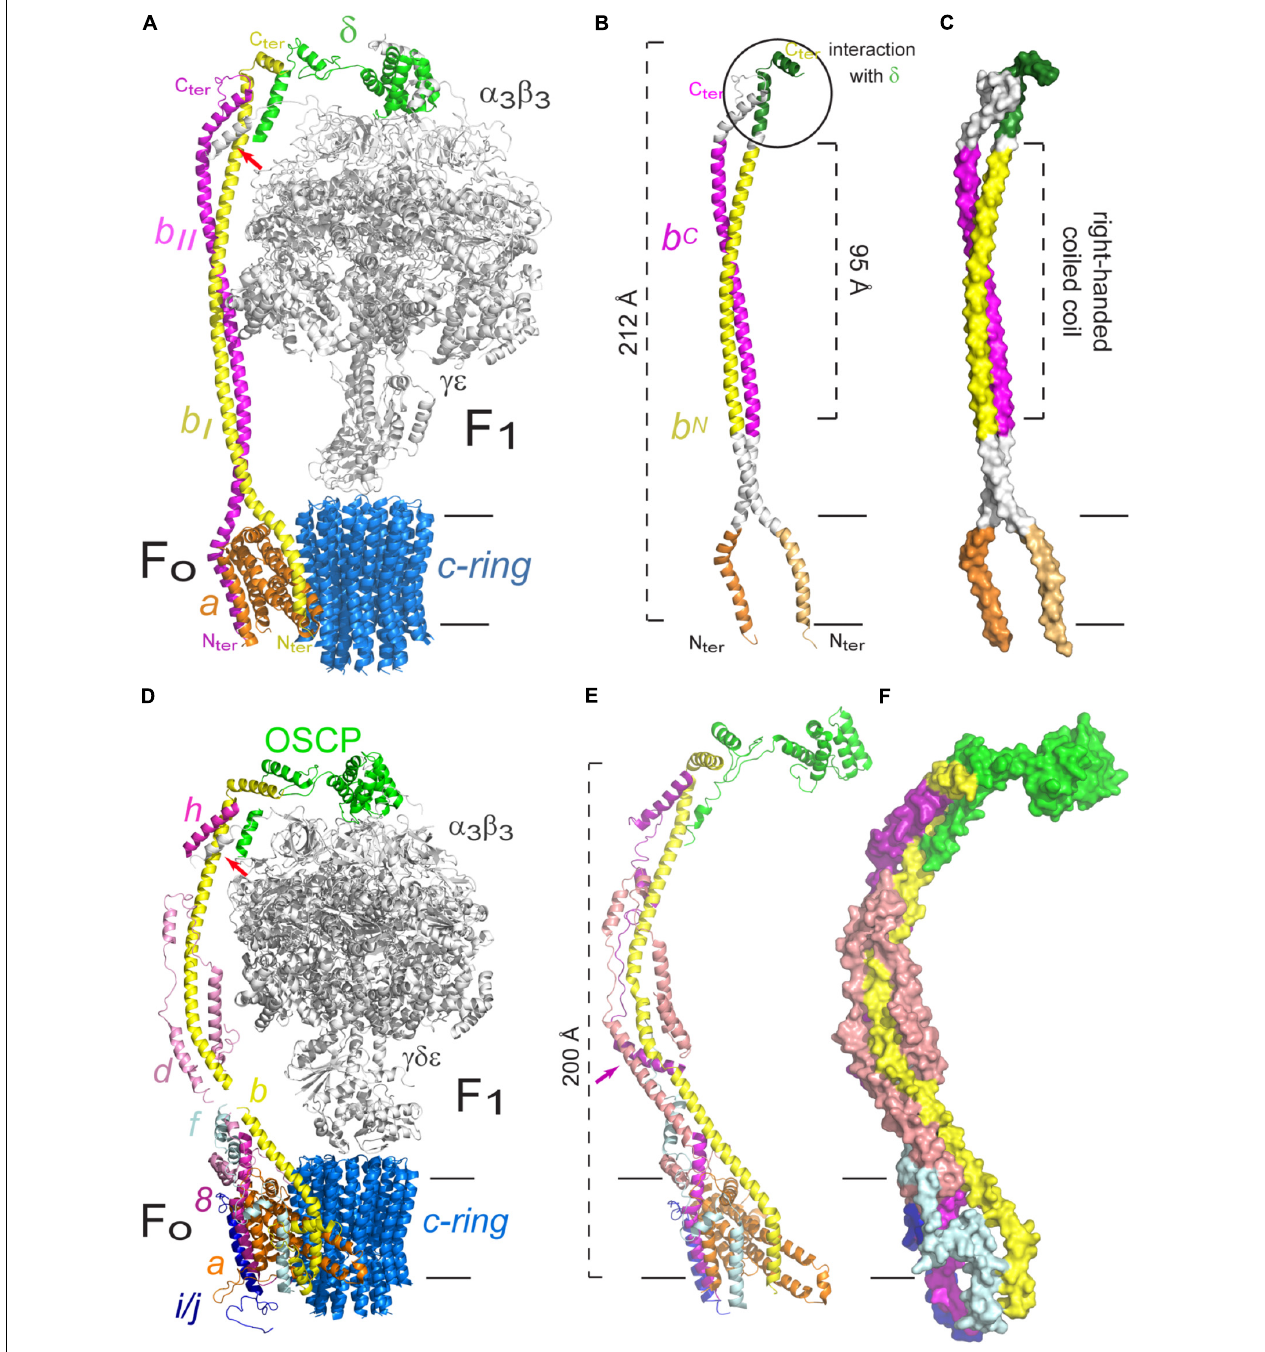
FIGURE 2 | Peripheral stalk of prokaryotic and eukaryotic F-ATPases. (A) Three dimensional model of the enzyme of Escherichia coli in which the peripheral stalk and the F O sector are colored. (B) Model that highlights the different domains of the b 2 dimer. The C-terminus (C-ter) and N-terminus (N-ter) of subunit b are indicated. (C) Model to illustrate the right-handed coiled coil domain of the b 2 dimer. The model used in A–C corresponds to the structural data deposited with the PDB 5T4O (Sobti et al., 2016). (D) Three dimensional model of the enzyme of Saccharomyces cerevisiae in which the peripheral stalk and the F O sector are colored. The helix of subunit α that contacts b , d and F6 is indicated with a red arrow. (E) Peripheral stalk of the yeast ATPase highlighting its components. The additional helix of subunit h is indicated with a purple arrow. (F) Surface representation to illustrate the coiled coil interactions in the extrinsic part of the yeast peripheral stalk. The model used in D–F corresponds to the structural data deposited with the PDB 6CP6 (Srivastava et al., 2018). The black horizontal lines indicate the mitochondrial inner